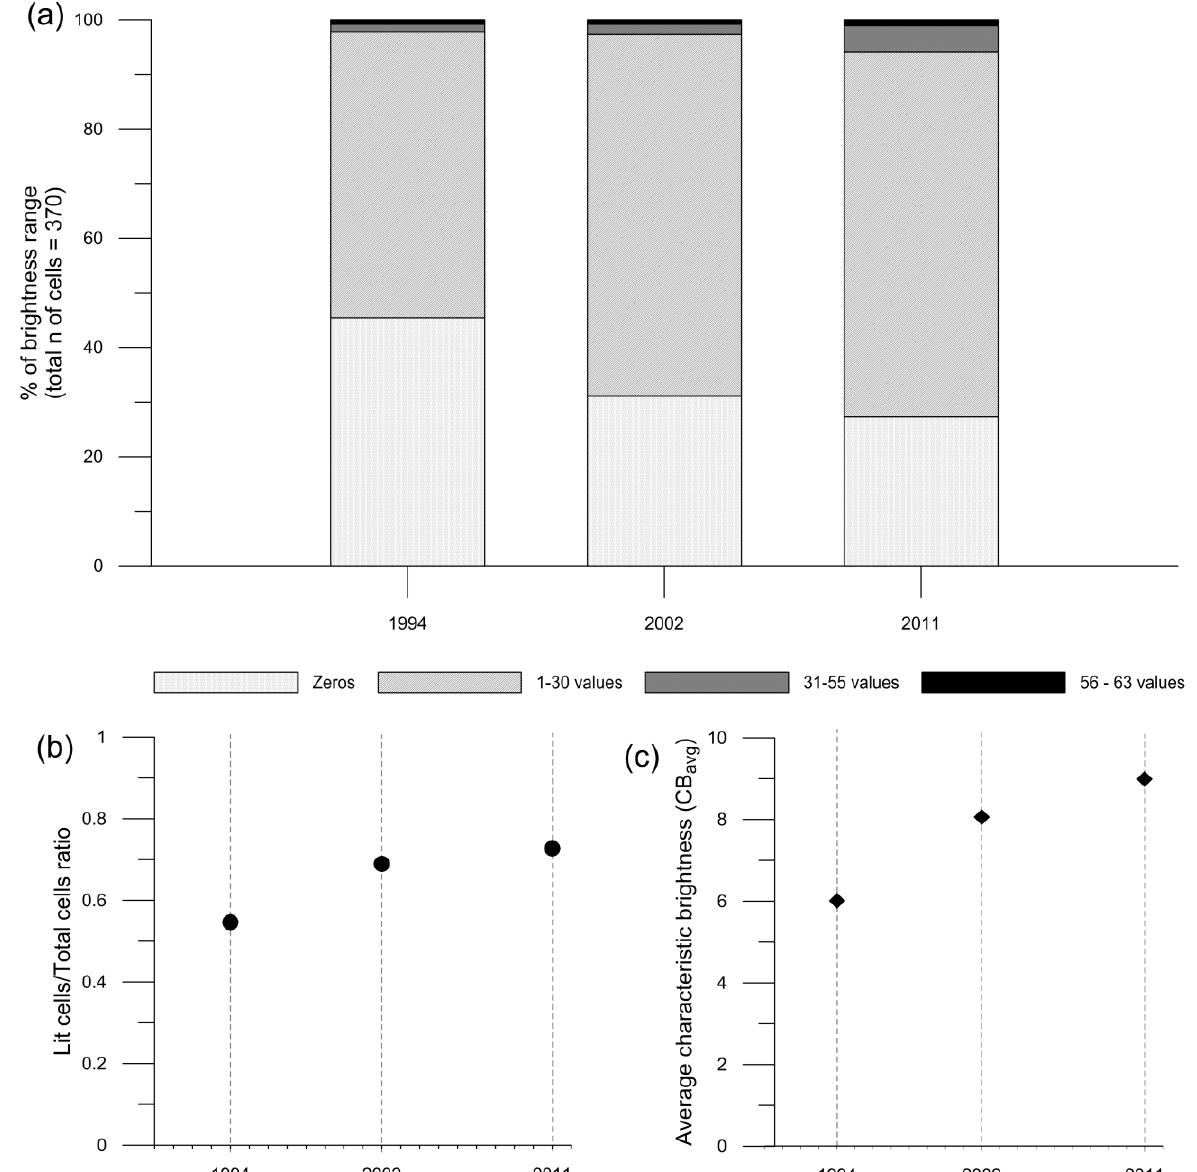
Figure 5. Nightlights in the close proximity of the Samala River over time. The evolution in time of nightlight cells corresponding with the river path (close proximity) is shown in terms of ( a ) distribution of cells per brightness ranges, ( b ) ratio of lit cells (cells that have recorded some light) to total cells, and ( c ) characteristic average digital number (CB avg